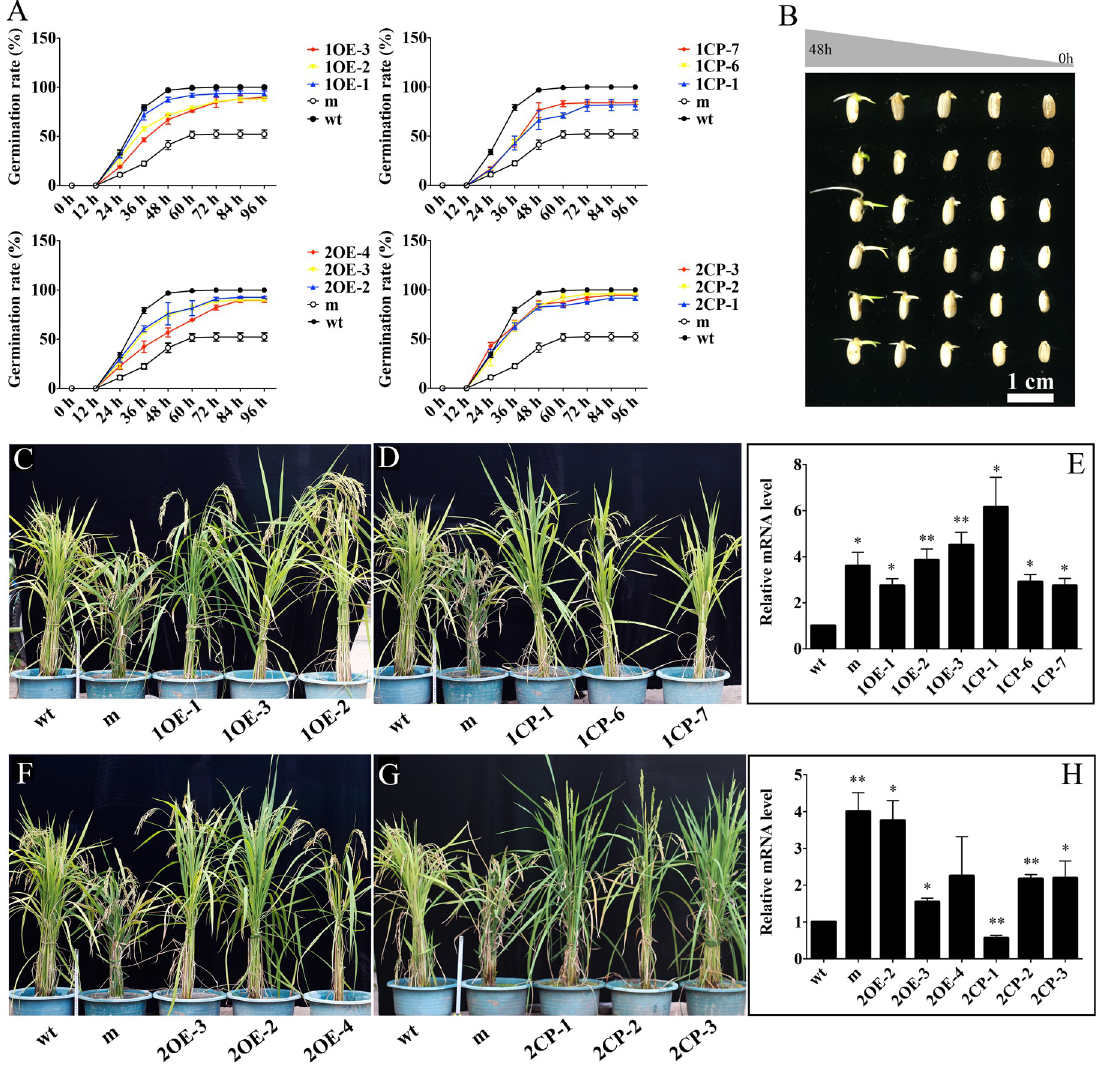
Fig 3. Genetic complementation analyses of the mutant. (A) Germination assay of wild type, mutant, and different transgenic lines. Upside and downside panels are the data for the overexpression (left) and native promoter lines (right) of OsKO1 and OsKO2 , respectively. (B) Images showing the germinating seeds from 0 to 48 h of different rice lines. (C) Rescue of the mutant phenotype in OsKO1 overexpression lines. (D) Rescue of the mutant phenotype in OsKO1 transgenic lines driven by its native promoter. (E) Expression of OsKO1 gene in different rice lines. (F) Rescue of the mutant phenotype in OsKO2 overexpression lines. (G) Rescue of the mutant phenotype in OsKO2 transgenic lines driven by OsKO1 native promoter. (H) Expression of OsKO2 gene in different rice lines. “wt”, wild- type; m, mutant; 1OE-1,2,3, OsKO1 gene overexpression transgenic lines; 1CP-1,6,7, OsKO1 gene native promoter transgenic lines; 2OE- 2,3,4, OsKO2 gene overexpression transgenic lines; 2CP-1,2,3, OsKO2 gene native promoter transgenic lines. Rice OsActin1 was used as internal reference for the qRT-PCR analysis. Data are means ± SE (n � 3). Significant difference was determined by Student’s t-test ( � p < 0.05, �� p <